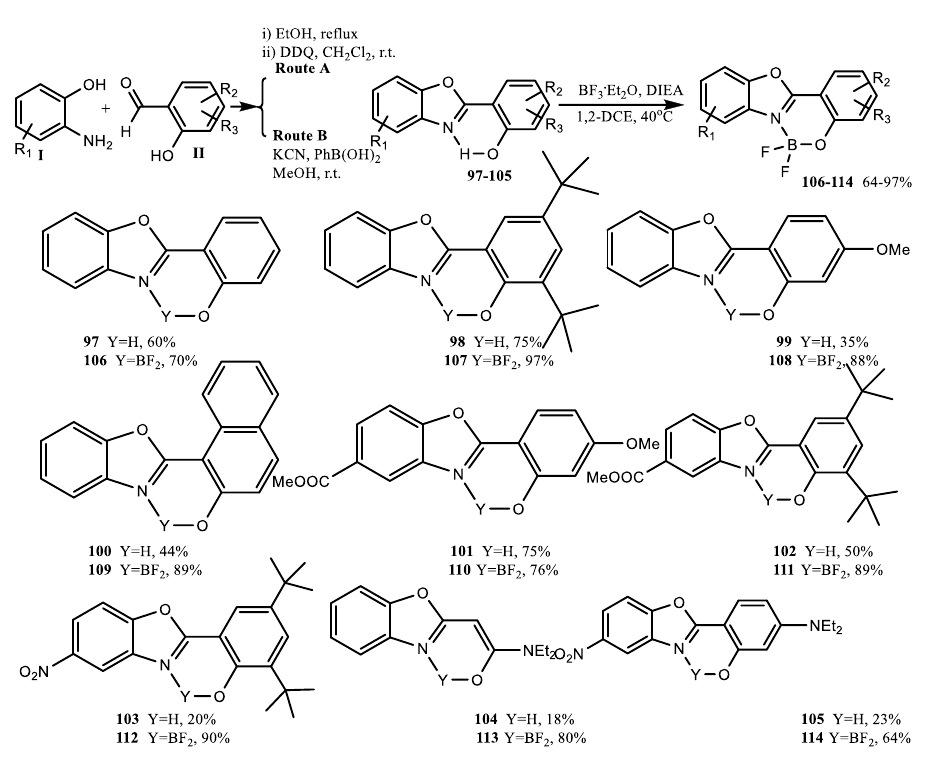
Scheme 20. Synthesis of substituted 2-(20-hydroxyphenyl)-benzoxazole (HBO) 97 – 105 derivatives and their corresponding B(III) complexes 106 – 114 .